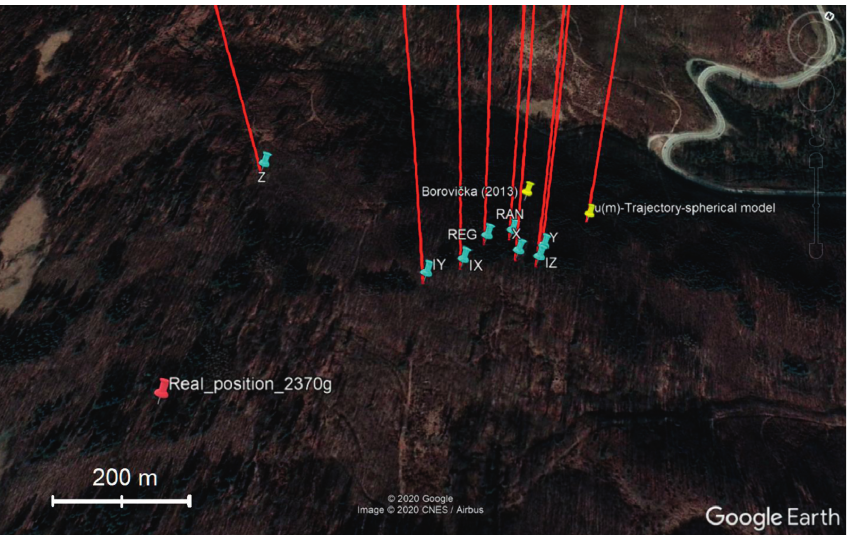
Figure 7: Detail on the impact area for the individual modeled orientations. On the left, the real place of recovered of the largest fragment of the Koˇsice meteorite. The position of the spherical model impact (yellow) from Boroviˇcka et al. [8] and μ (m)-Trajectory program. Table 3: Values of the drag coefficient Γ for individual orientation of the Koˇsice fragment no. 21 (208 g) in selected altitudes [15]. Altitude